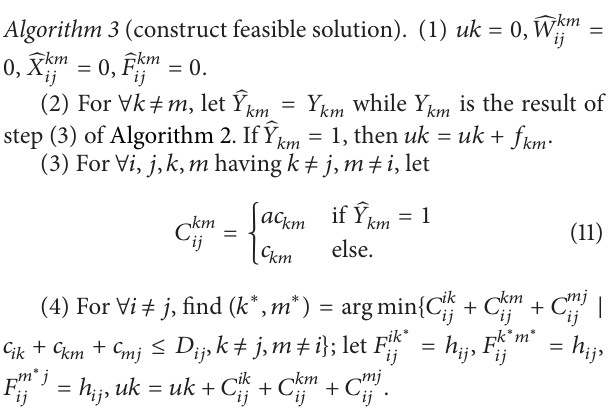
Algorithm 4 (Lagrangian relaxation algorithm for